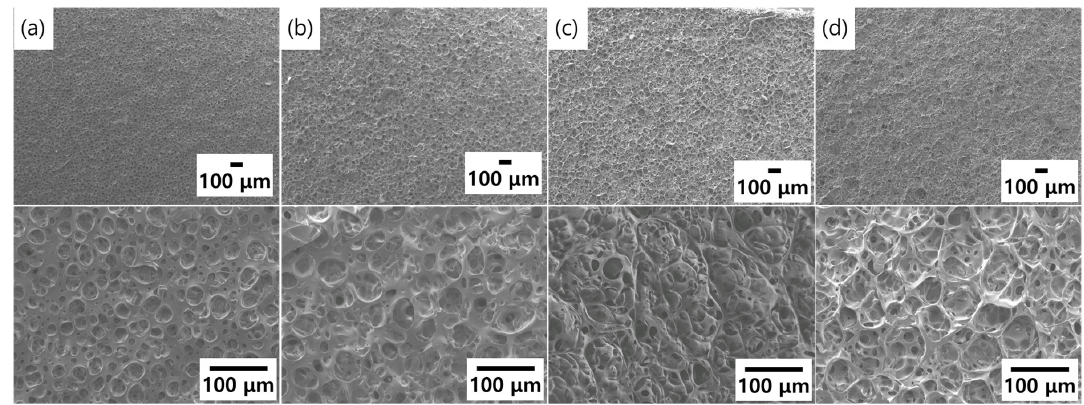
Figure 3. FE-SEM images of surface of the formed porous layer with ( a ) 1:1 wt% (400 cp); ( b ) 2:1 wt% (800 cp); ( c ) 5:1 wt% (2100 cp); and ( d ) 10:1 wt% (3000 cp) of uncured PDMS solution.